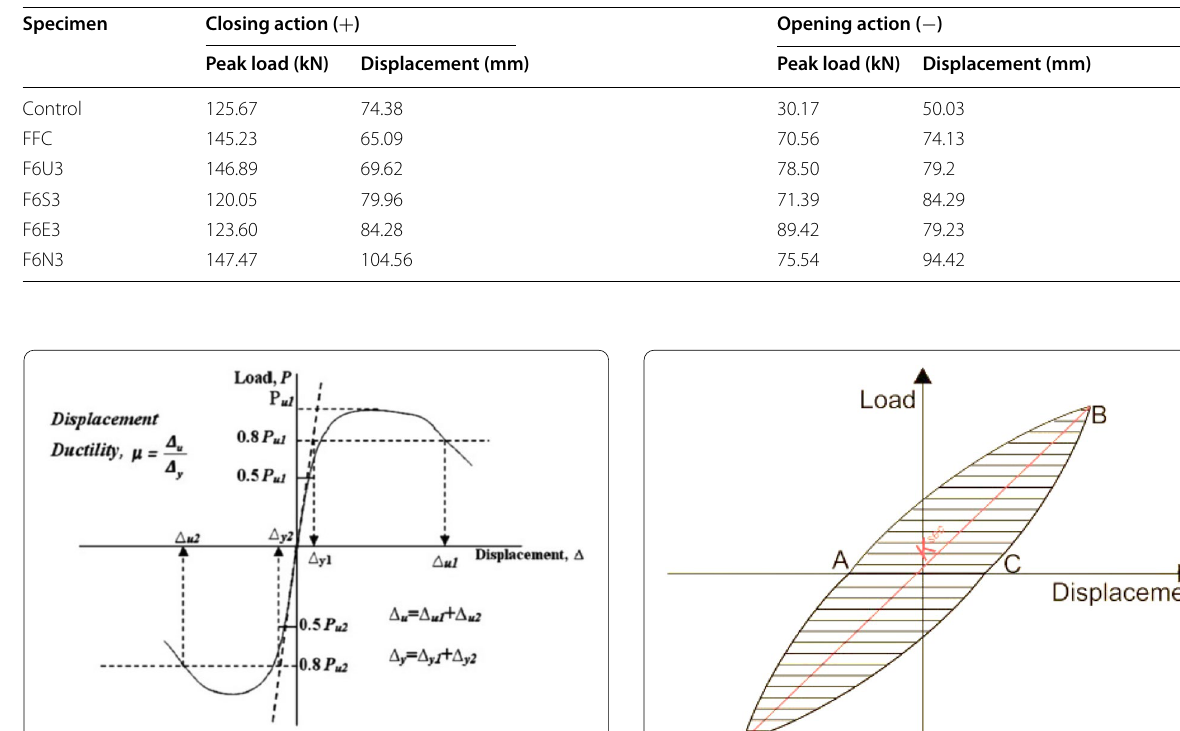
Fig. 12 Calculation for displacement ductility (Chidambaram and Agarwal 2015)